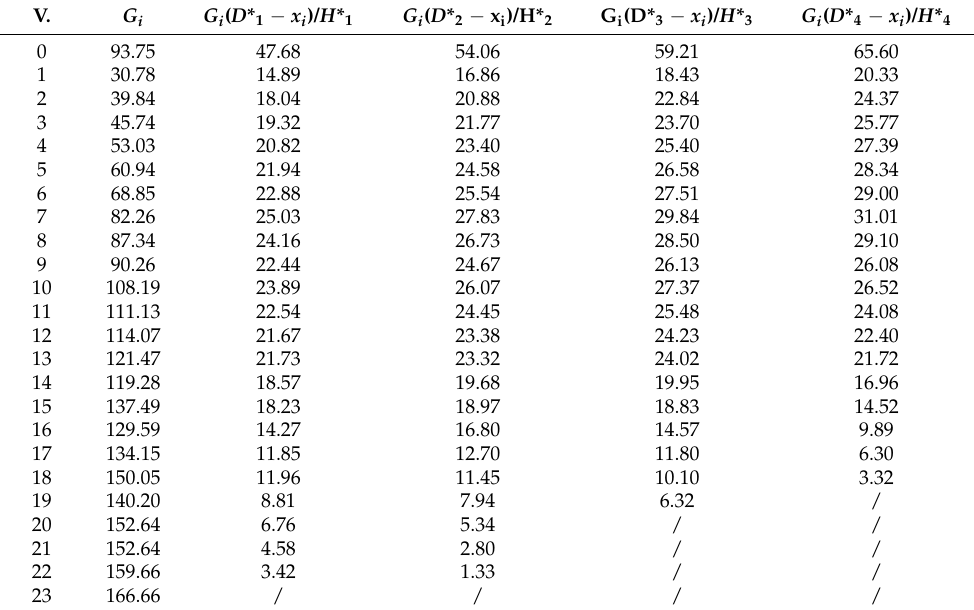
Table 2. Calculation of the kinematical